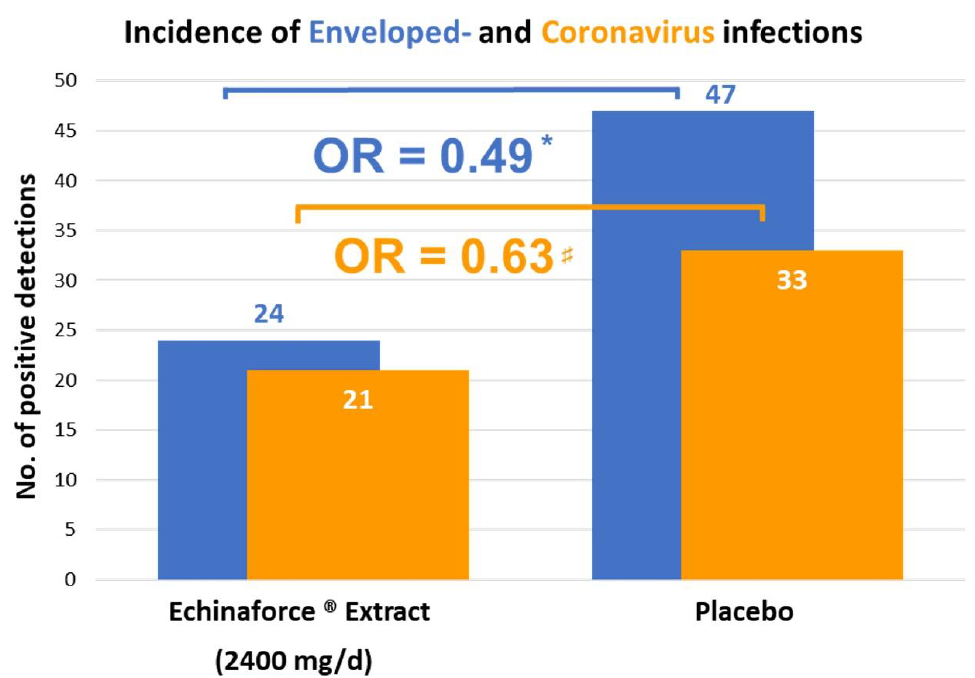
Figure 2. Echinacea significantly prevented enveloped virus infections (blue bar, * p = 0.0114), includ- ing coronaviruses 229E, HKU, NL63 and OC43 (orange bar, # p > 0.05), as measured by Jawad et al. 2012. Prevention of coronaviruses was significant for the ITT sub-group ( p = 0.010). In a second blinded, multi-center RCT, the same Echinacea extract formulated in tablets was given to children 4 to 12 years old living in central Switzerland [26]. Here, the authors chose low-dose vitamin C 3 × 50 mg/d as control. The commercial product was the child-friendly Echinacea formulation (Echinaforce ® Junior tablets, A. Vogel AG, Roggwil, Switzerland, also licensed as phytopharmaceutical drug) with a recommended dose of 1200 mg/d for children over 4 years. This trial enrolled 203 principally healthy children in the winter season of 2016/17, of which N = 103 were randomized to Echinacea 3 × 400 mg/d and N = 98 to Vitamin C 3 × 50 mg/d. The preparations were administered over a period of 4 months, including a 1-week treatment break after 2 months. Parents recorded and reported symptoms in their children using a validated scoring manual de- veloped by Taylor and colleagues and collected a nasopharyngeal sample on day 2 of any episode [29]. The probe was sent for analysis using semi-quantitative RT-PCR (Allplex Respiratory Full Panel Assay, Seegene Inc., Seoul, South Korea), and the following path- ogens were tested: rhinovirus, adenovirus, enteroviruses, respiratory syncytial virus, in- fluenza and coronaviruses (229E, OC43 and NL63). The methodological quality according to Jadad et al. [24] was 4 points, which was again considered high. Overall, 57 and 72 samples were positively tested for ribonucleic acid (RNA) from any respiratory virus during prevention with Echinacea and control, respectively ( p = 0.0074, X 2 test). Similar to the results obtained from adults, Echinacea significantly reduced the incidence of enveloped virus infections in children with a total of N = 29 samples com- pared to control with N = 47 yielding a significant odds ratio of OR = 0.43 ( p = 0.0038, X 2 test). Again, information relating to coronavirus subtypes was retrieved from study au- thors retrospectively: coronavirus incidence was, at 13 and 11 positive samples in the in- tention-to-treat sample, insignificantly different between interventions ( p > 0.1). Two CoV episodes in each group pre-existed at inclusion and were thus not regarded for prevention analysis, but for evaluation of treatment benefits. In contrast to the earlier study by Jawad